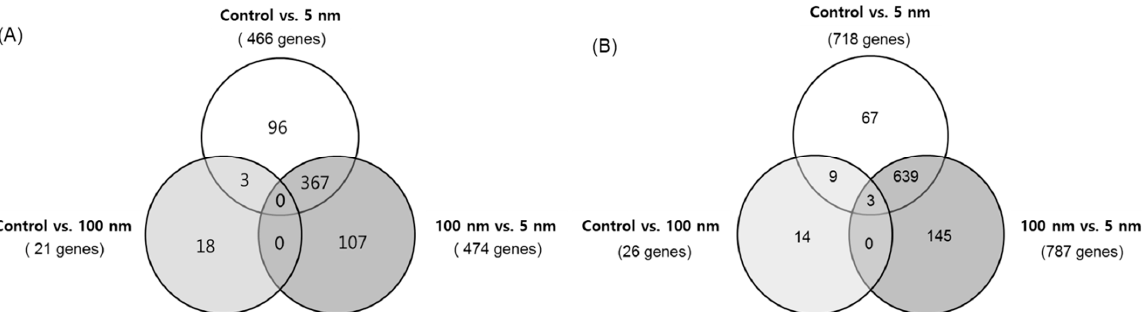
Figure 3. Microarray analysis to determine increased gene expression changes. ( A ) EA.hy926 cells were exposed to silver NPs at their approximate LD 50 (2 µg/mL) for 6 h. ( B ) BEAS-2B cells were exposed to silver NPs (0.5 µg/mL) for 6 h. Results were analyzed using a t -test, and significance was set at p < 0.05.